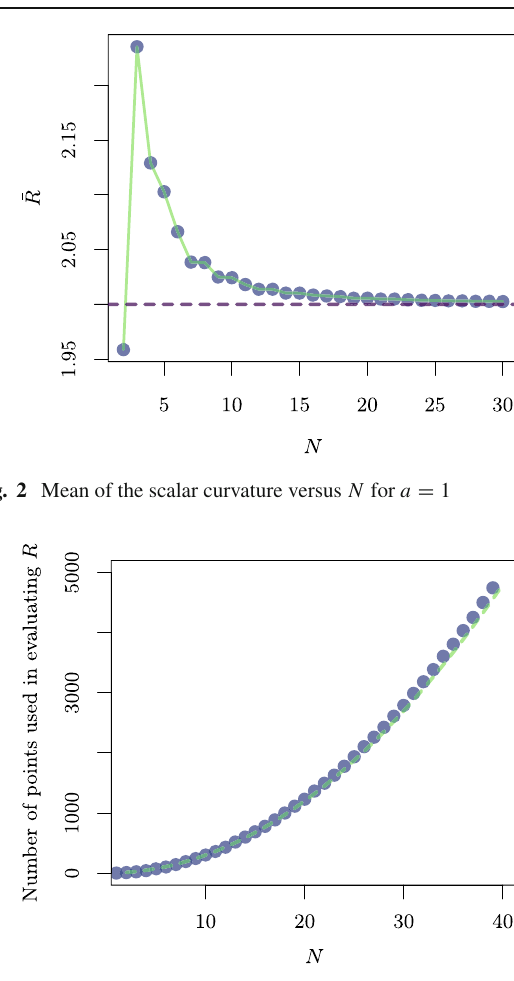
Fig. 3 The estimate of the number of points used in evaluating R , 3 N 2 , is represented by the light green curve. The actual number of points satisfying Eq. (6), retrieved numerically, and contributing to the computation of R , is represented by the blue dots